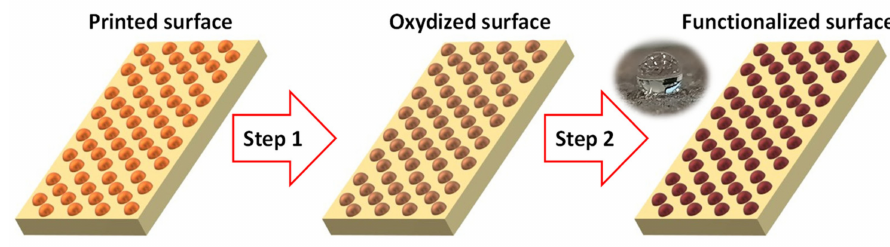
Figure 1. General concept of two step post printing